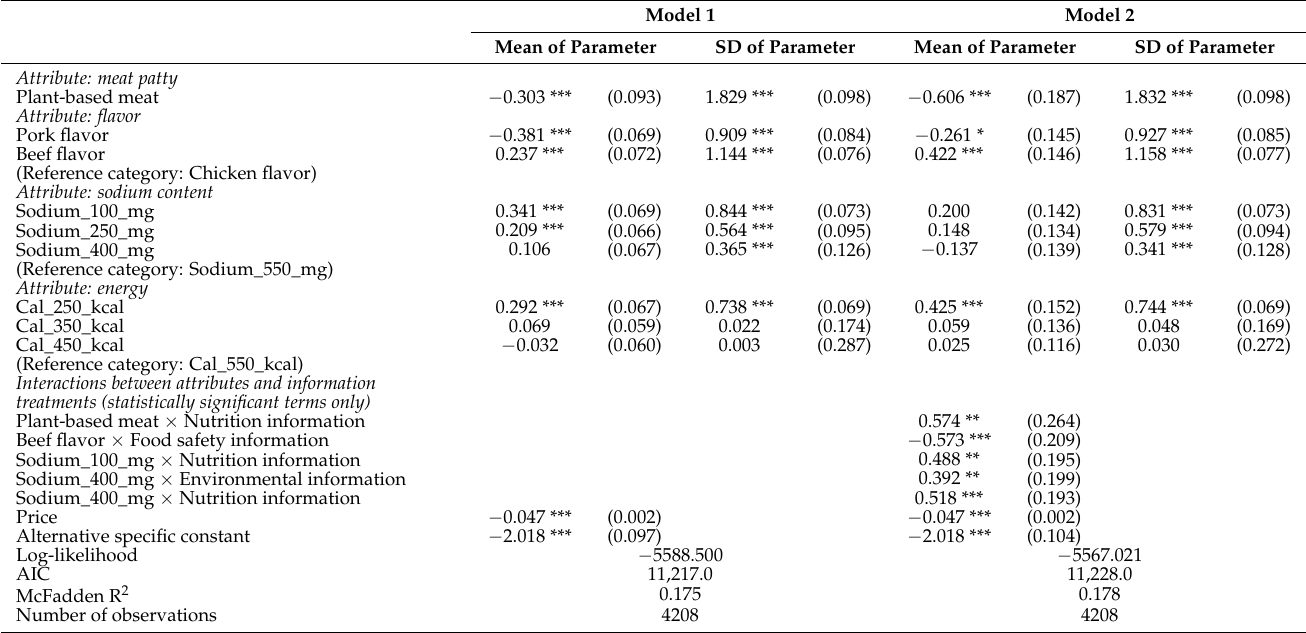
Table 4. Mixed-logit estimates.